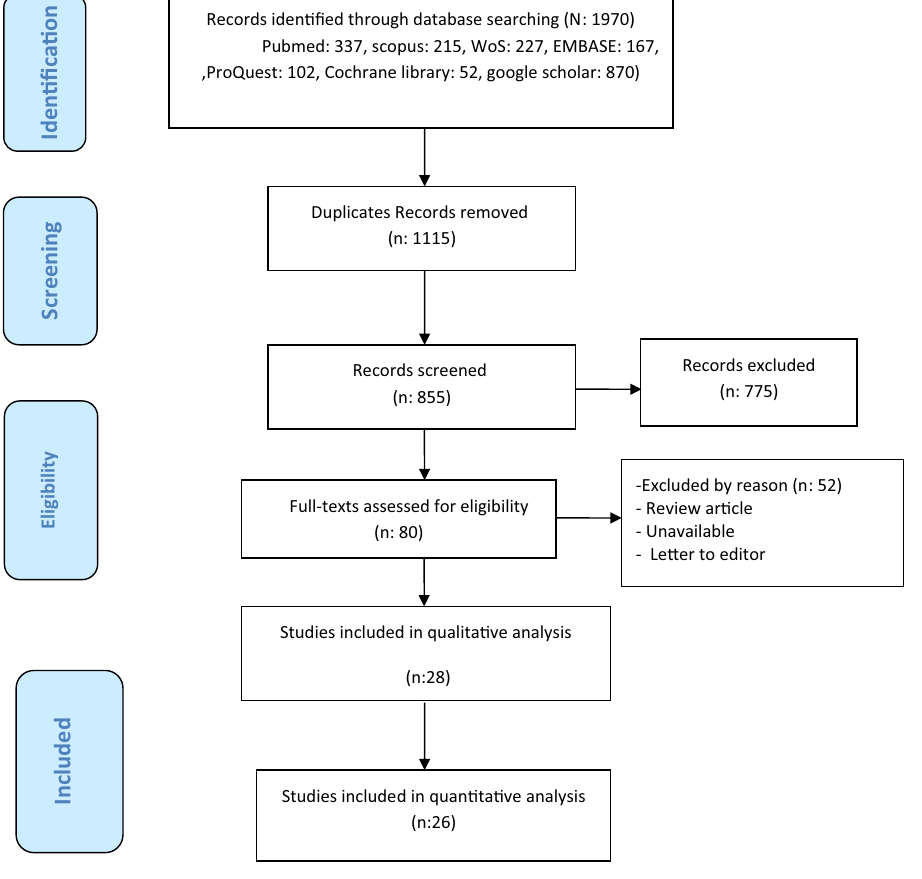
Figure 1. PRISMA diagram for searching